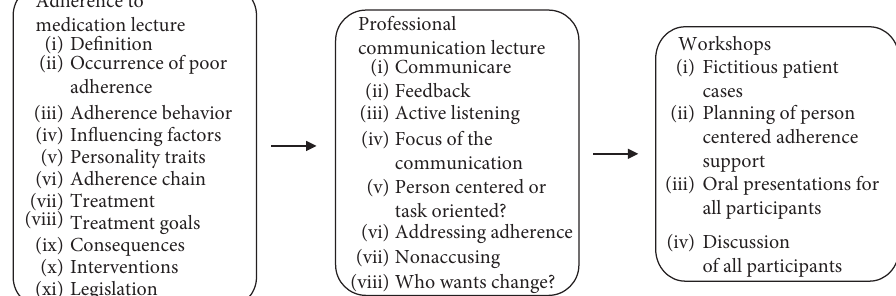
Figure 1: Overview of the content in the educational intervention. Table 1: Description of the three fictitious patient